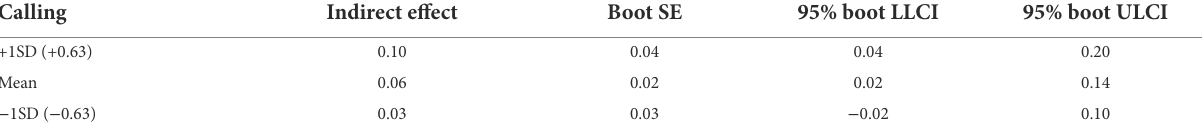
TABLE 5 The results for the conditional indirect effect analysis. Calling